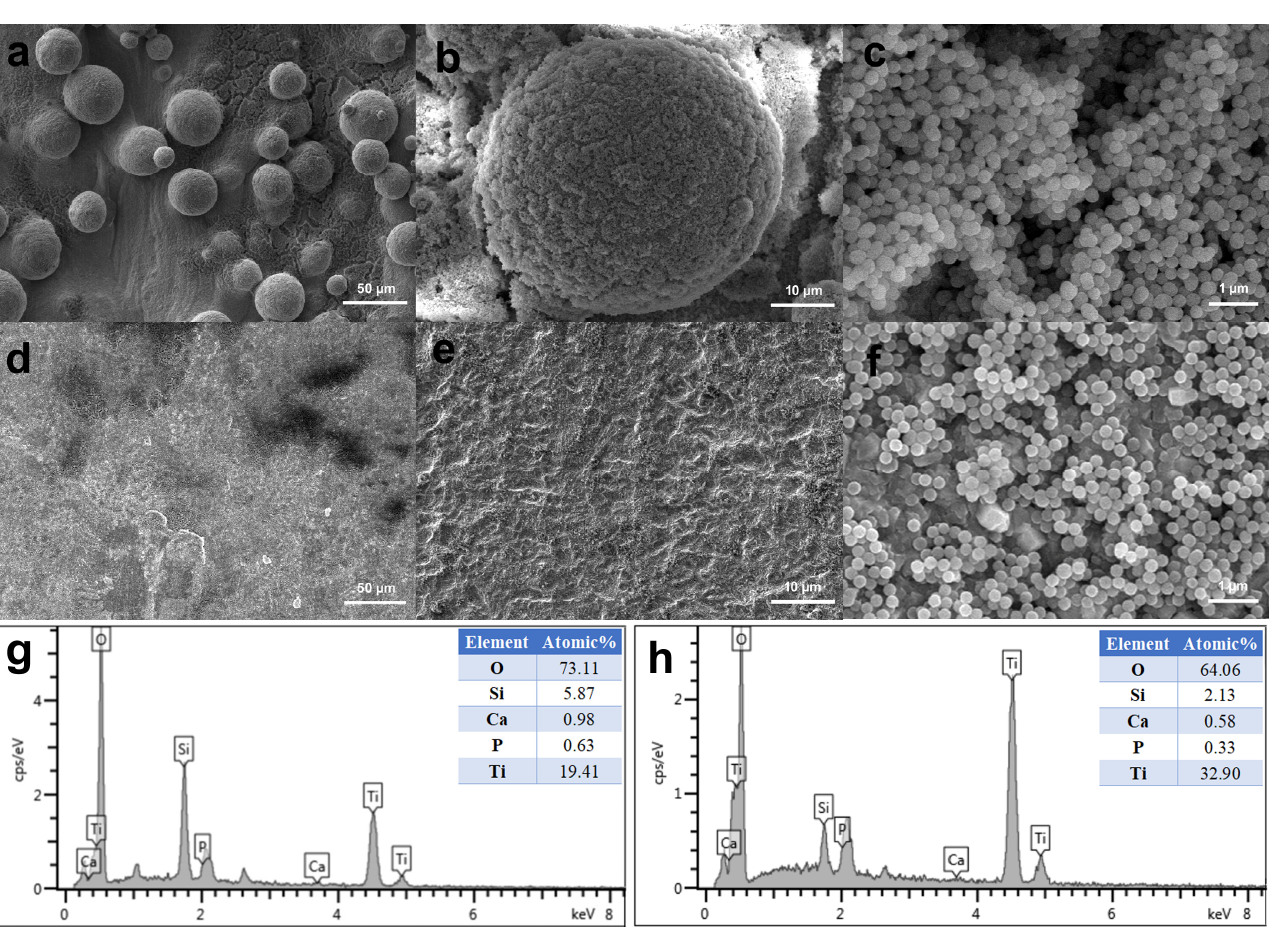
Figure 3. Morphologies of MBG-coated SLM-Ti ( a – c ) and CP-Ti ( d – f ) by dip coating, and EDS analysis of MBG-SLM-Ti ( g ) and MBG-CP-Ti ( h ).